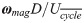
Normalized vorticity magnitude (ωmagD/Ucycle¯), and normalized swirl (SD) for three cardiac phases at the same Y − Z slice shown in Fig 6.Every third vector in each direction is shown.